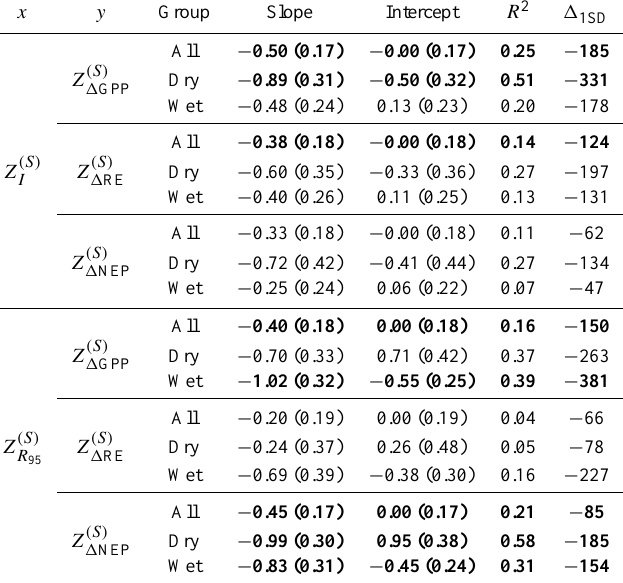
Table 5. Slopes, intercepts (both with standard errors in parentheses) and R 2 values for linear regressions between site-level standardised ecosystem flux residuals and precipitation variables, for all sites and for precipitation groups defined in Table 2. Regressions significant at the 5% level are indicated in bold. Since all values are standardised, all values in the table are unitless, except for column 1 1SD , which shows the change in ecosystem flux (gCm − 2 yr − 1 ) associated with a one standard deviation change in the predictor variable, Z I or Z R